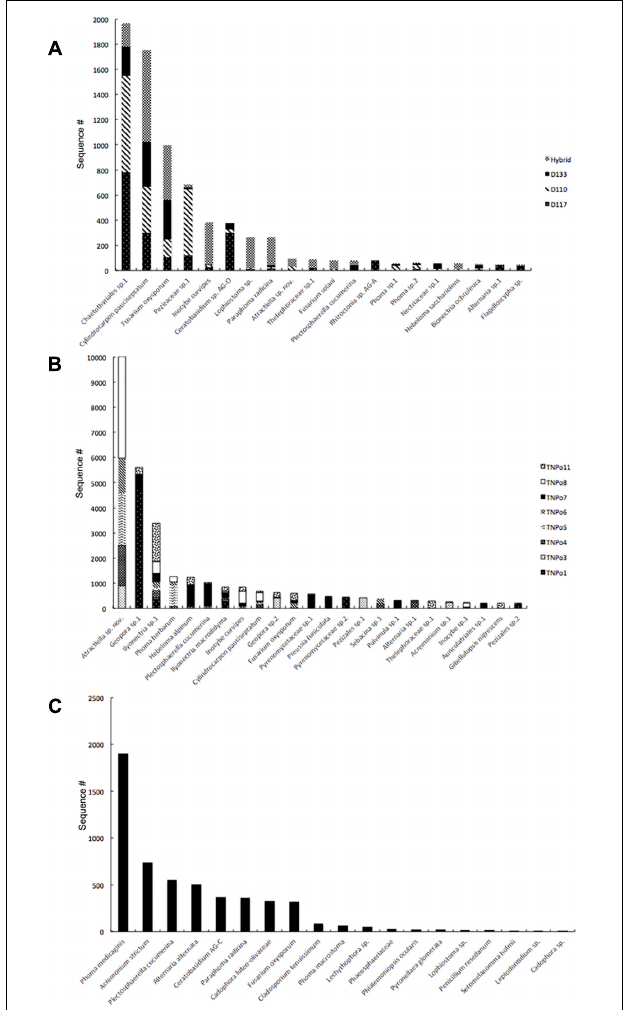
FIGURE 1 | Rank abundance of fungi in Populus roots based on ITS rDNA amplicon sequencing. (A) Across different genotypes (Experiment 1); (B) Across different soils (Experiment 2); (C) In uninoculated control plants.